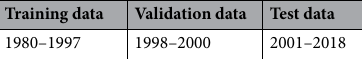
Table 2. Year span for each data set.